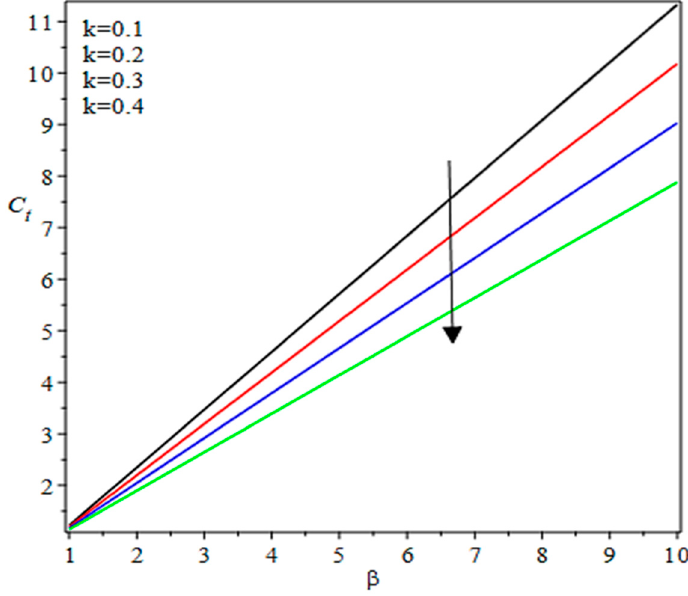
Figure 28. Influence of Br on the temperate distribution at ξ = 0.75.